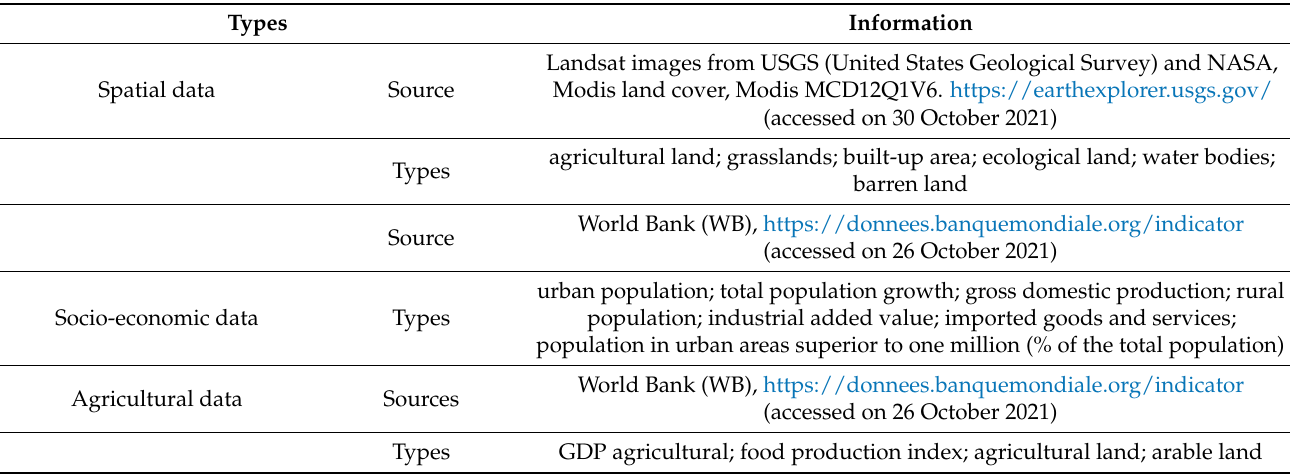
Table 2. Data sources